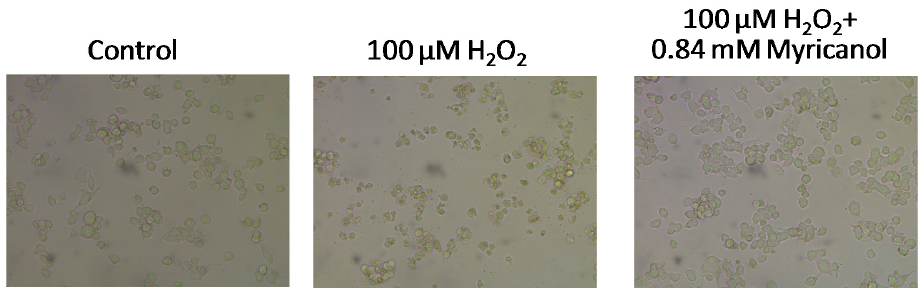
Figure 6. Effect of myricanol on H 2 O 2 -induced cell morphological changes.